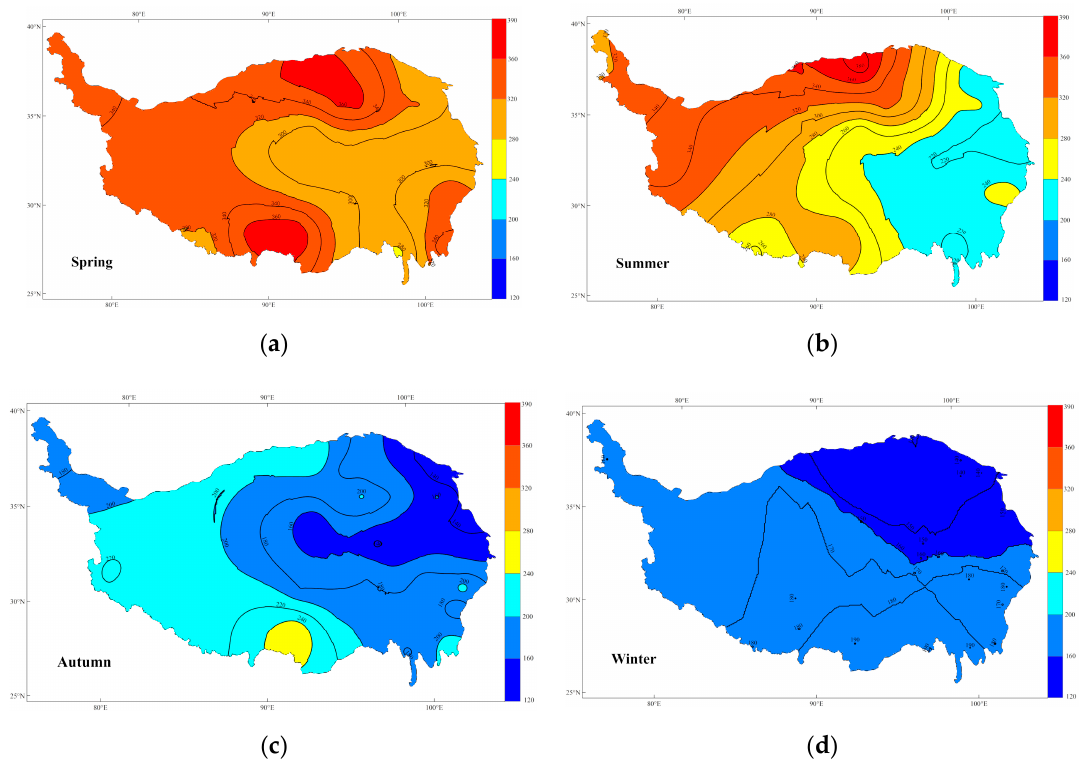
Figure 8. The spatial distribution of ET 0 in the four seasons, where ( a ) is spring; ( b ) is summer; ( c ) is Figure 8 autumn; ( d ) is